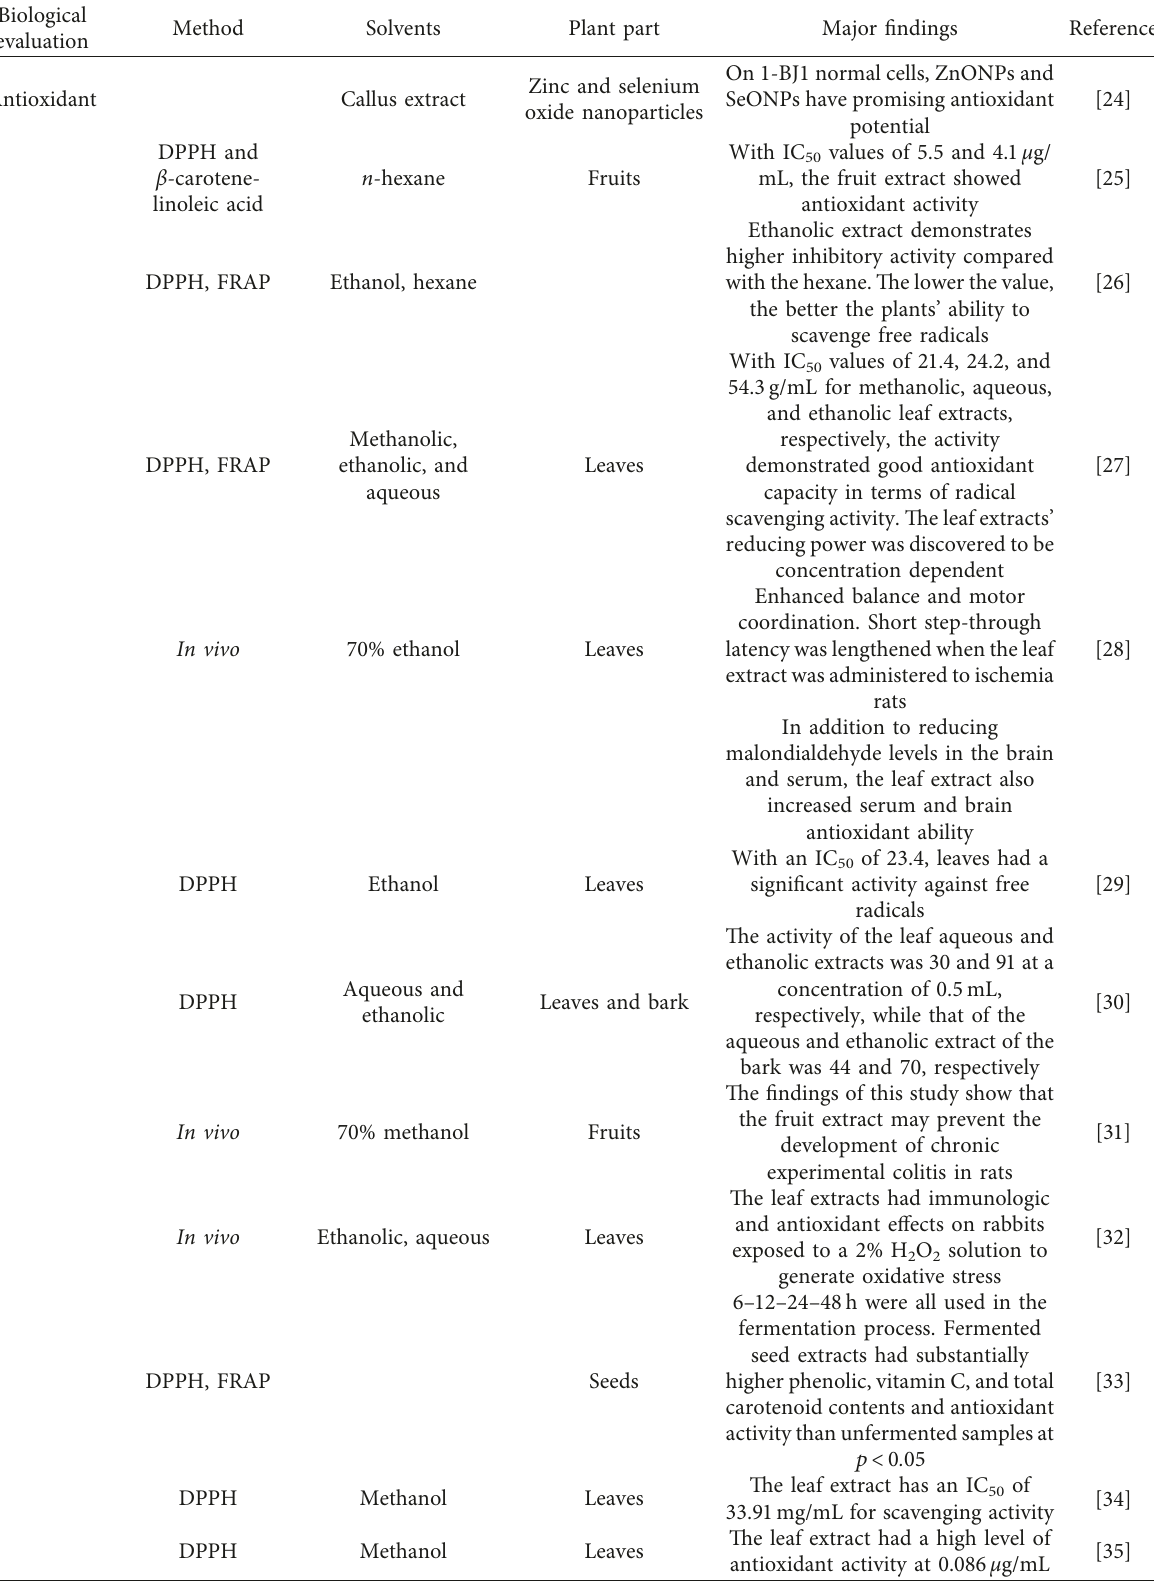
Table 1: Biological evaluation of Z. spina